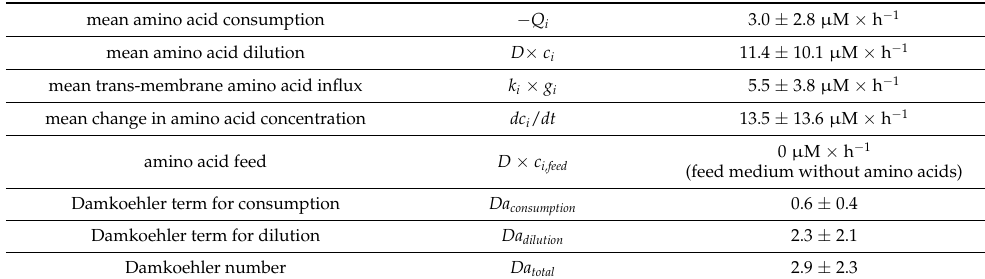
Figure 7. Illustration of terms to estimate the Damkoehler number ( Da ) during the continuous mode. Trans-membrane transport provided amino acids; Streptococcus thermophilus or Lactobacillus delbrueckii subs. bulgaricus consumed amino acids; and the continuous mode provoked amino acid washout. The initial concentration for some amino acids was above zero at the start of the continuous mode. Table 1. Comparison of mass balance terms for amino acids in the compartment containing Streptococcus thermophilus.